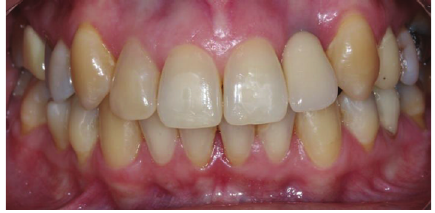
Figure 6: Esthetic restoration.